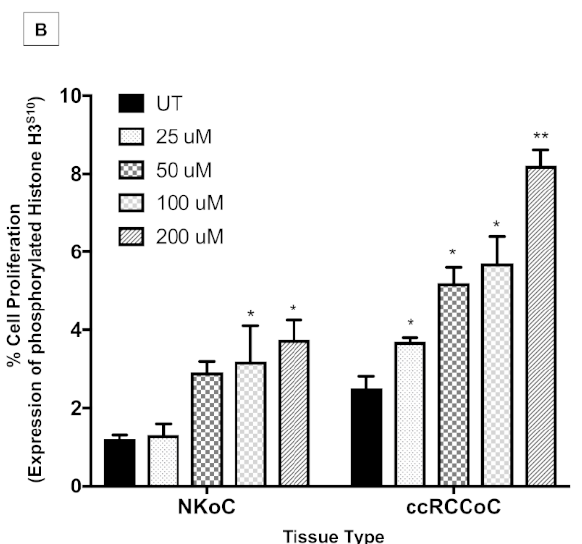
Figure 5. Effects of different doses of sunitinib on cell death (detected by TUNEL) and cell proliferation (detected by anti-phosphorylated histone H3 S10 immunostaining) in organ cultures of human normal kidney and ccRCC organ cultures. N = 3 with similar results. Statistical significance compared to untreated controls (UT) is indicated as; * P < 0.05, ** P < 0.01, *** P < 0.001, + P < 0.0001. NK—** P < 0.01—UT vs. 25 µM; *** P < 0.01—UT vs. 50 or 100 µM; + P < 0.0001—UT vs. 200 µM. ccRCC—** P < 0.001—UT vs. 25 µM or 50 µM; + P < 0.0001—UT vs. 100 µM or 200 µM. In contrast, sunitinib induced minimal cell proliferation, significantly only at a high dose as compared to UT controls (NKoC- p < 0.05 (UT vs. 100 or 200 µ M); RCCoC- + p < 0.05 (UT vs. 50 or 100 µ M and ** p < 0.01-UT vs. 200 µ